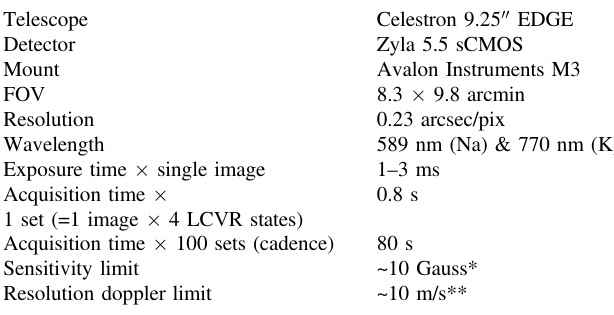
Table 1. Main characteristics of the SAMM